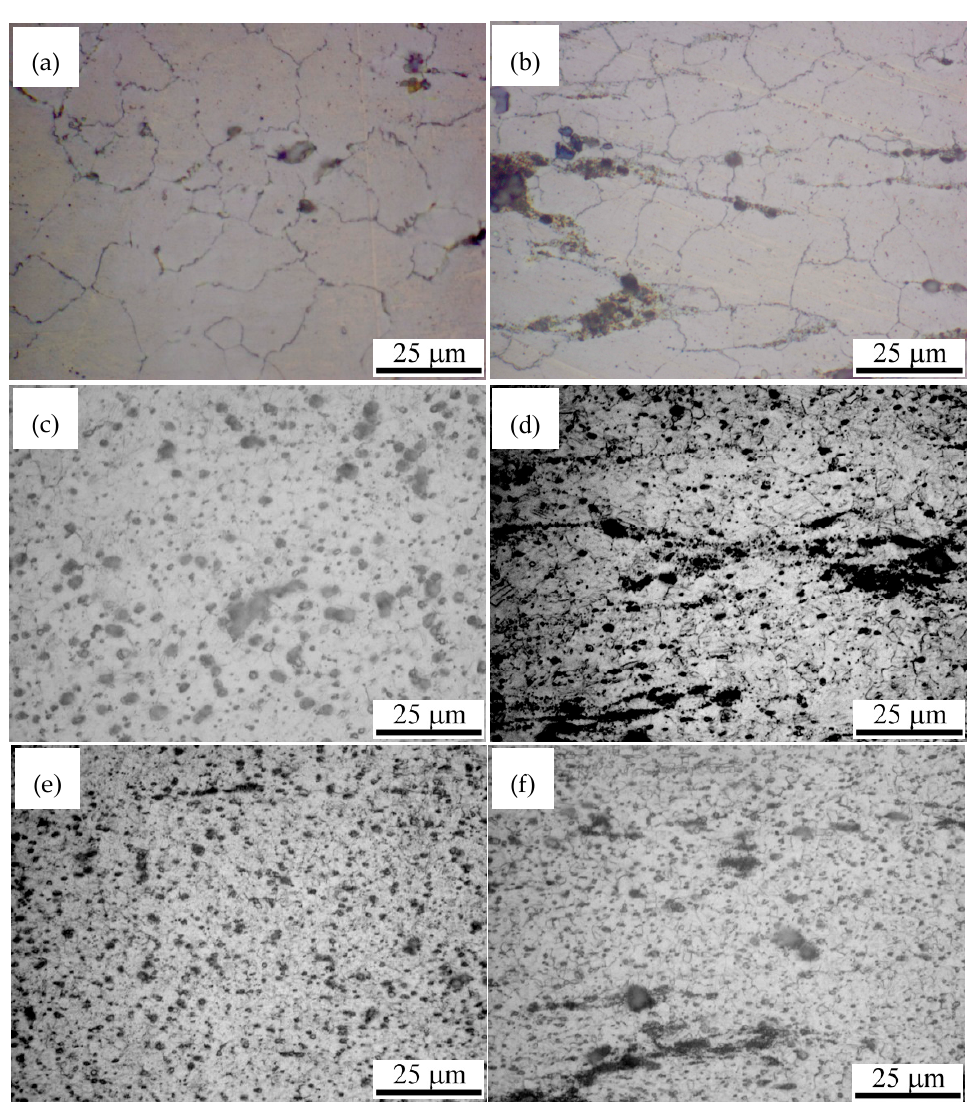
Figure 1. OM images of AZ91 alloy after multi-pass forging for ( a ) six passes, ( c ) nine passes, ( e ) 12 passes, and nano-SiCp/AZ91 composites after multi-pass forging for ( b ) six passes, ( d ) nine passes, ( f ) 12 passes (six passes–400-6P, nine passes–400-6P + 350-3P, 12 passes–400-6P + 350-3P + 300-3P).